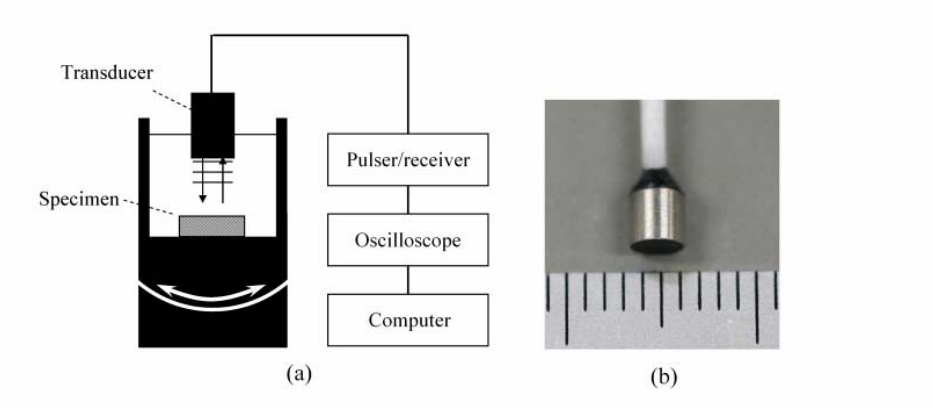
Figure 2: (a) Schematic drawing of the ultrasound measurement system. A small transducer was fixed over the measurement device. The measurement was performed in water at room temperature and the A-mode echogram was measured. (b) Ultrasound transducer (diameter: 2mm, frequency: